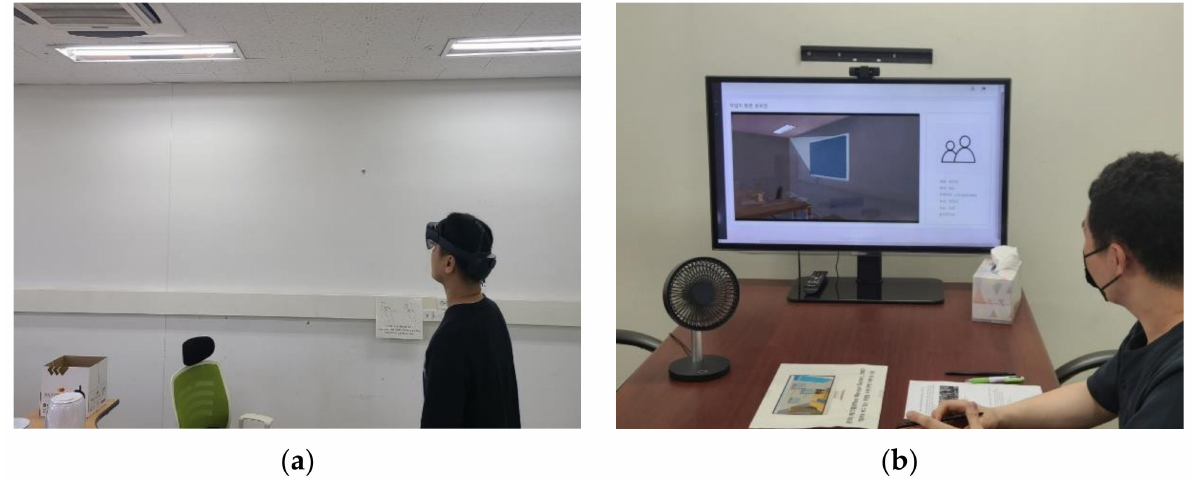
Figure 8. FOS user with HoloLens 2 and OMS user seeing the FOS user’s view: ( a ) FOS user wearing a HoloLens 2; ( b ) OMS user watching FOS user’s